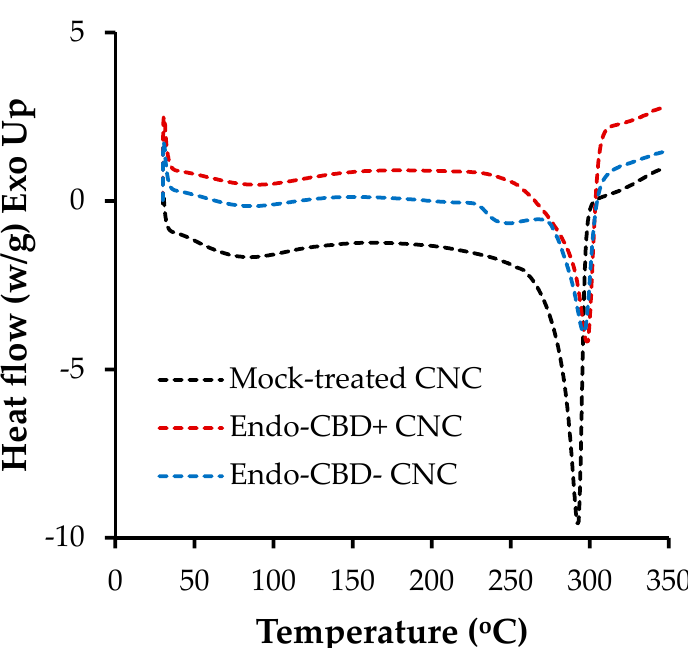
Figure 6. DSC thermograms of CNC samples. The CNCs that were generated through acid hydrolysis of wood pulp subjected to a mock-treatment or a treatment with endoglucanases with (Endo-CDB+) or without (Endo-CBD − ) a cellulose-binding domain (1.0 U/g of pulp loading) were analyzed via DSC. The results shown above represent the average of duplicate experiments.